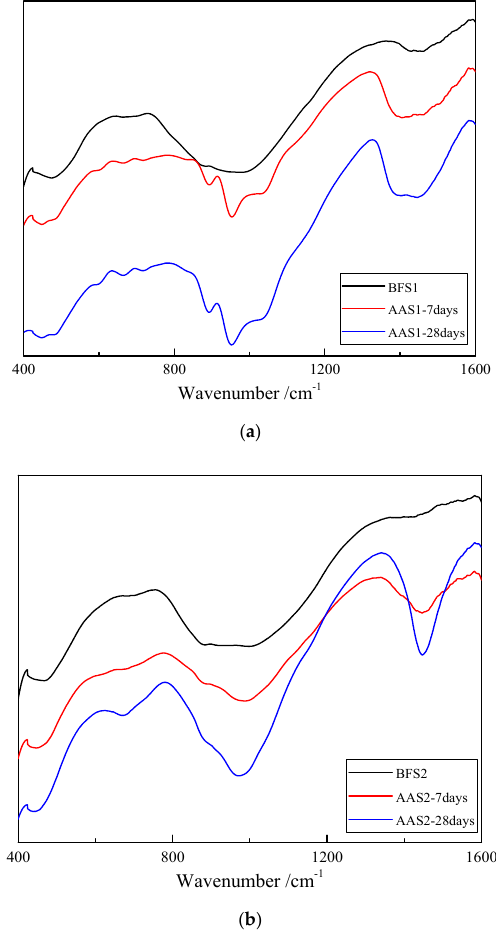
Figure 4. Results of the FTIR analysis.( a ) AAS1 and ( b ) AAS2